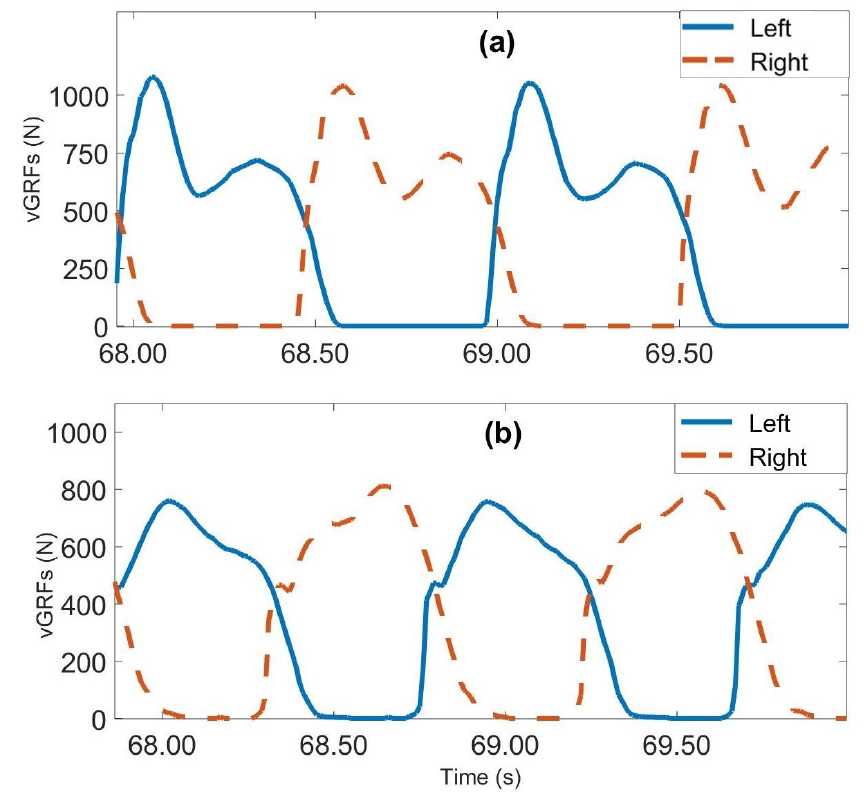
Figure 3. vGRFs measured on left foot (blue) and right foot (red); ( a ) healthy subject, ( b ) subject with